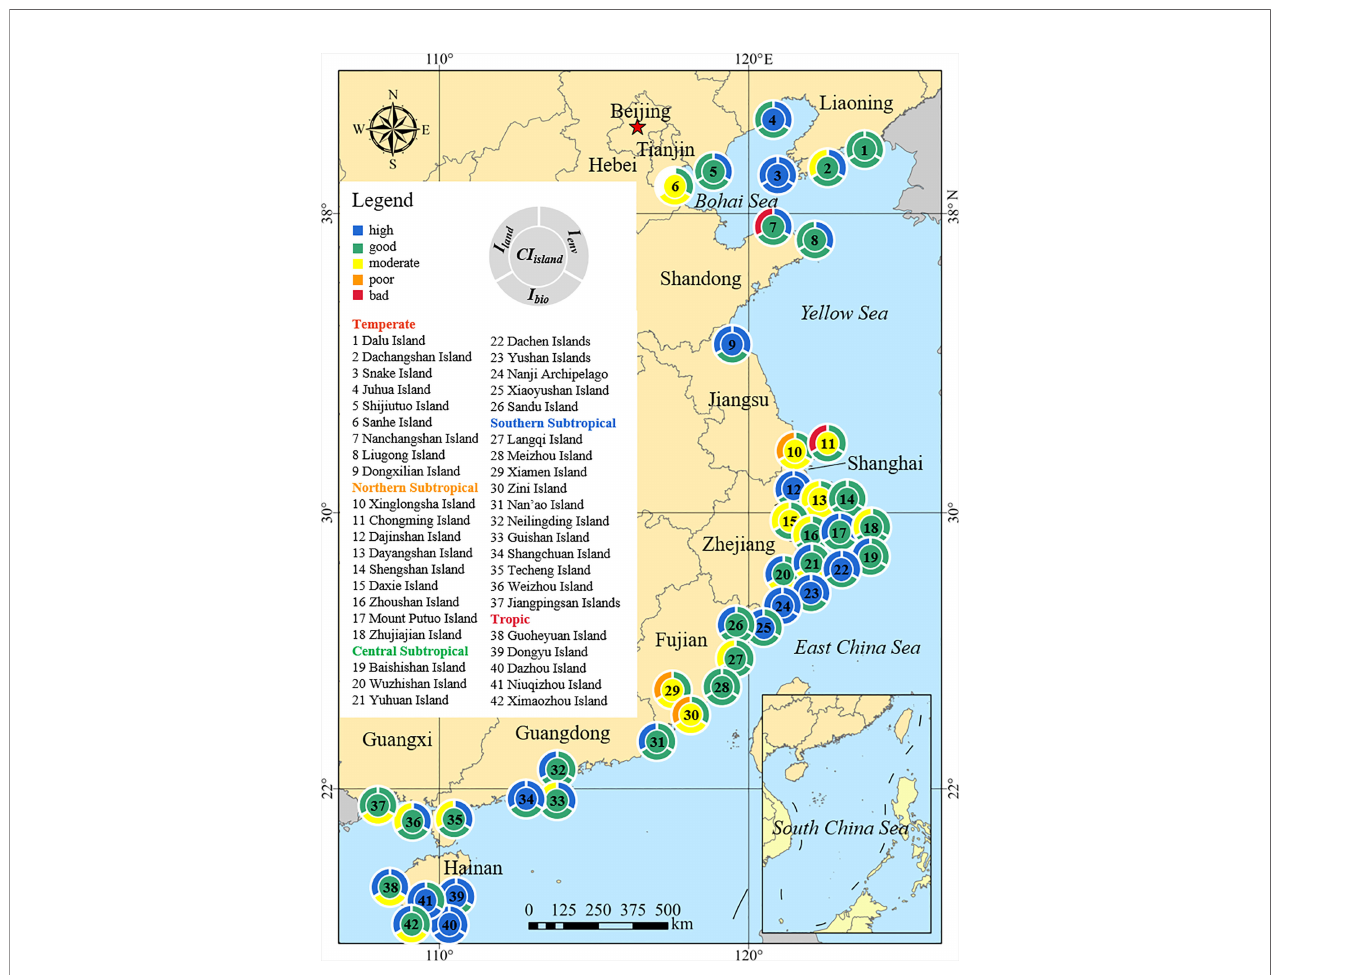
FIGURE 5 | The overall condition of island ecosystem in China